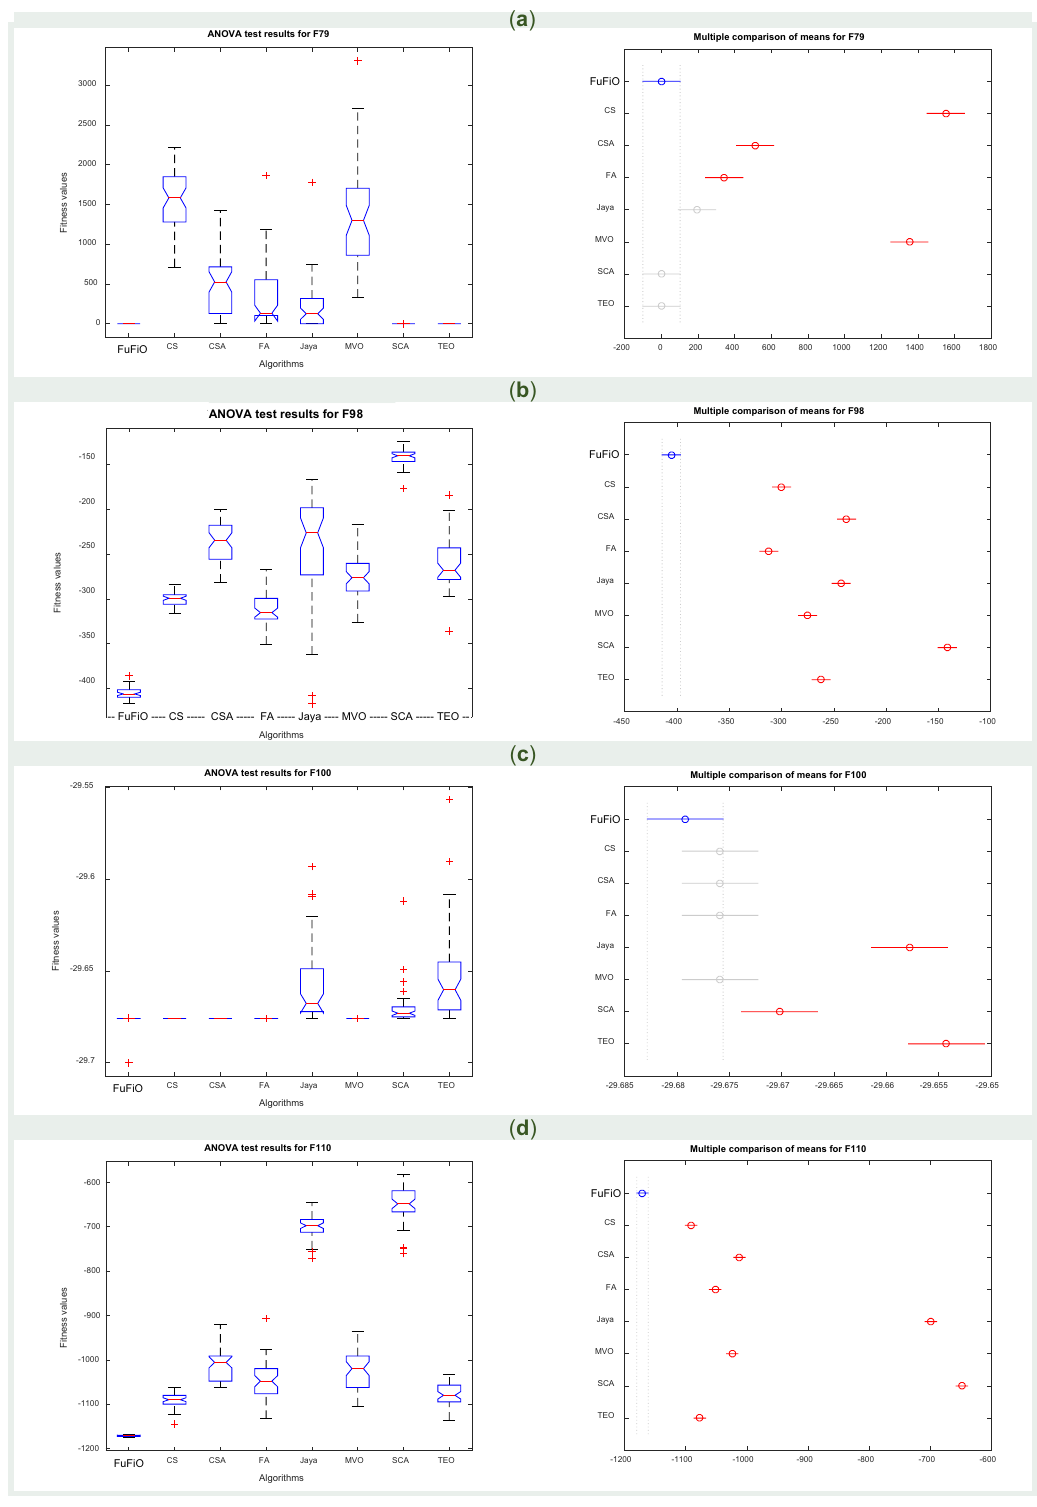
Figure 14. ANOVA test results for N -dimension